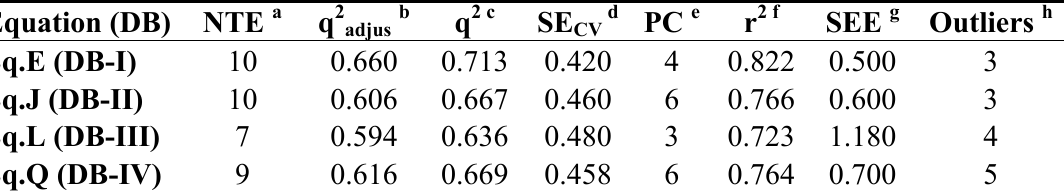
Table 3. Statistical results of the best equations of DB-I to DB-IV .